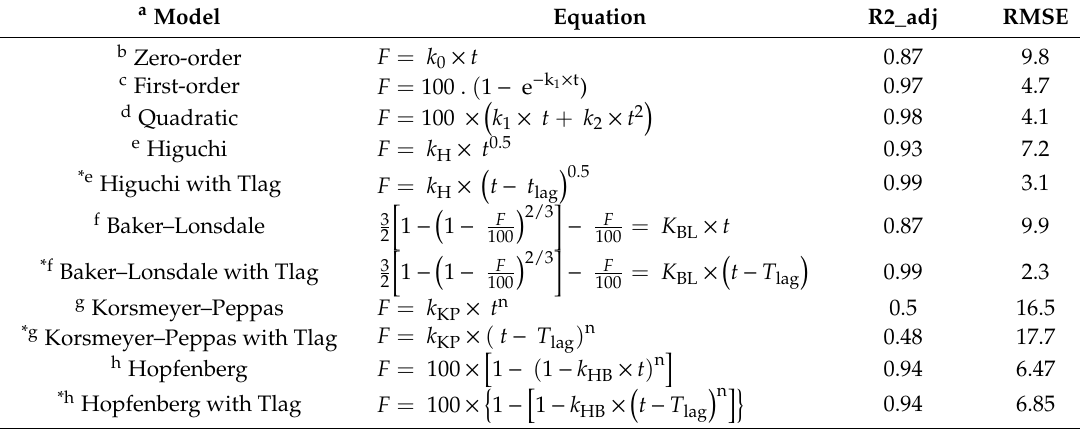
Table 1. Di ff erent mathematical models used for fitting experimental data and their equations with the values of the statistical